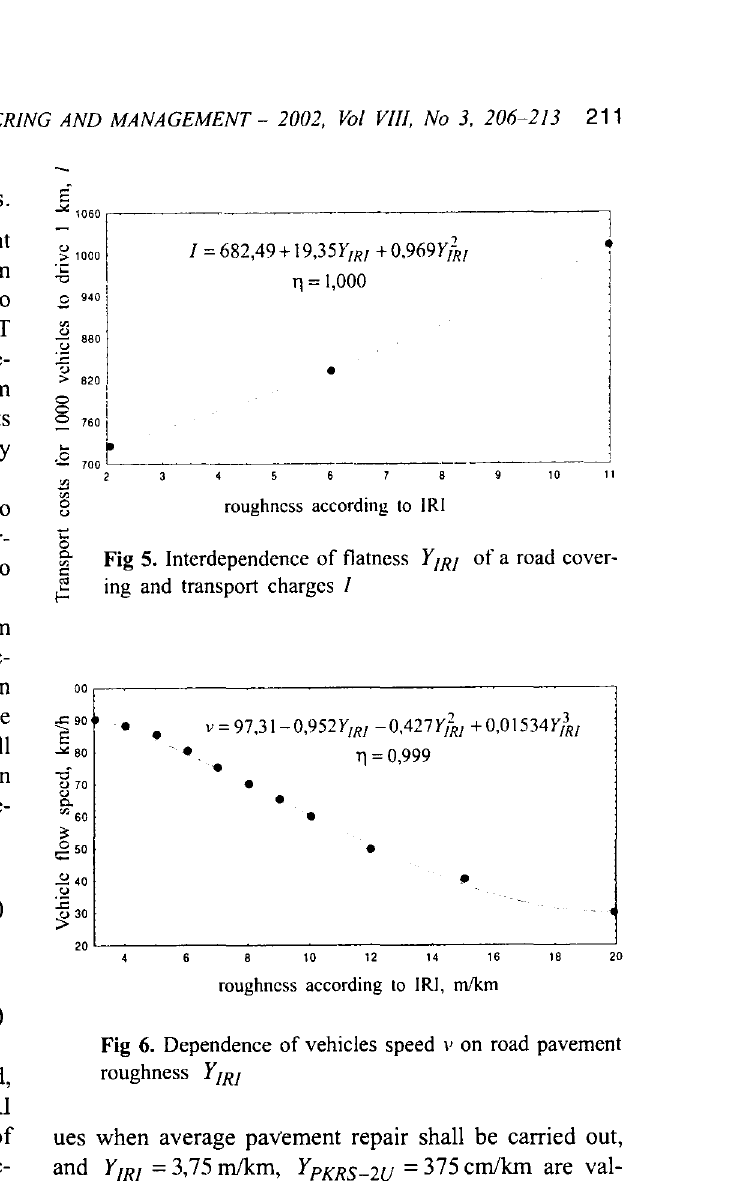
Fig 6. Dependence of vehicles speed v on road pavement roughness YIRI